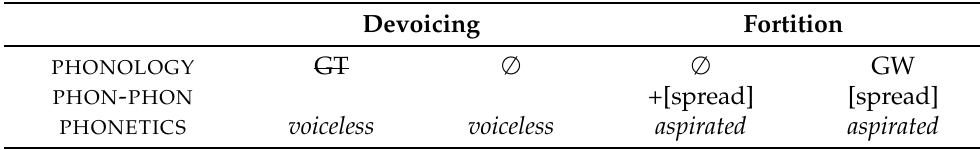
Table 5. Comparison of devoicing and